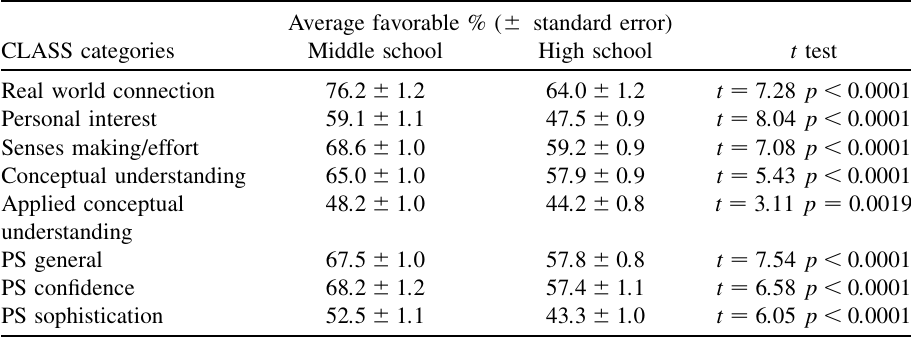
TABLE III. Middle school and high school students’ favorable percentages on eight CLASS